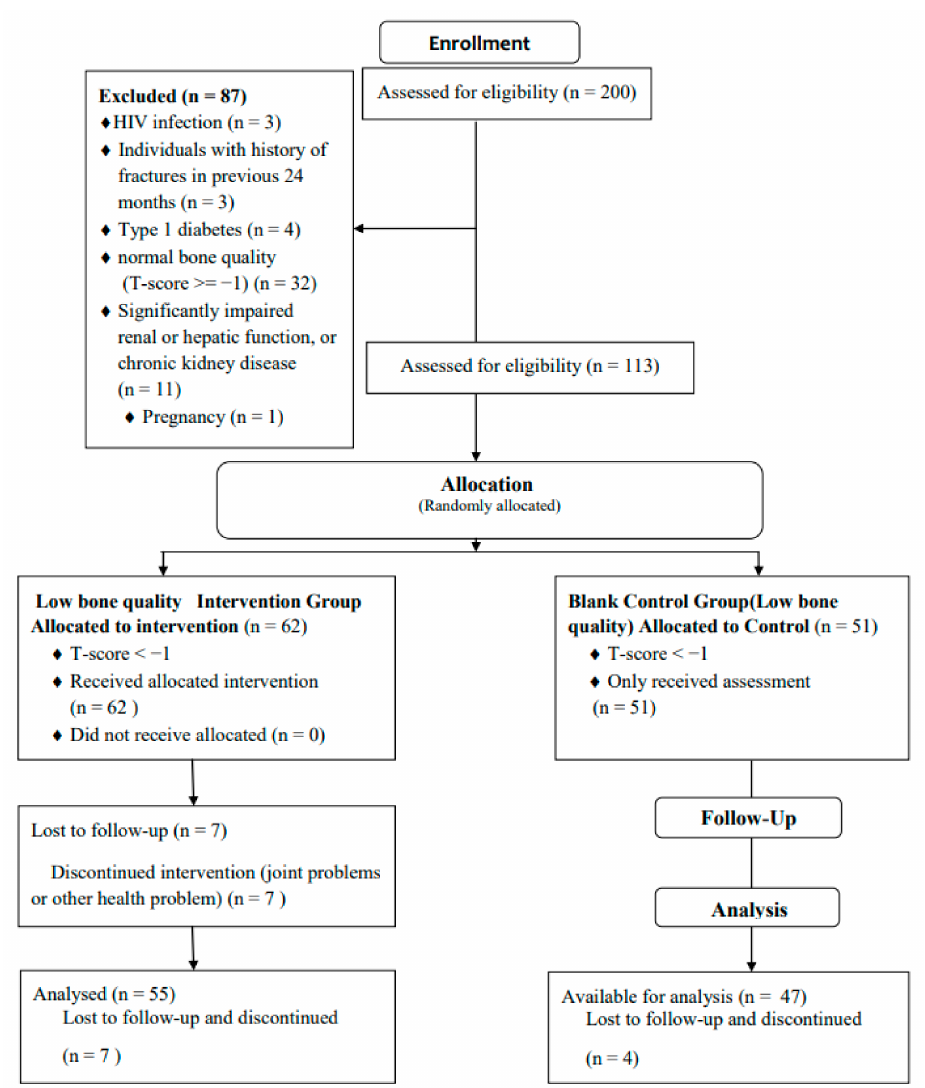
Figure 1. Flow chart of this